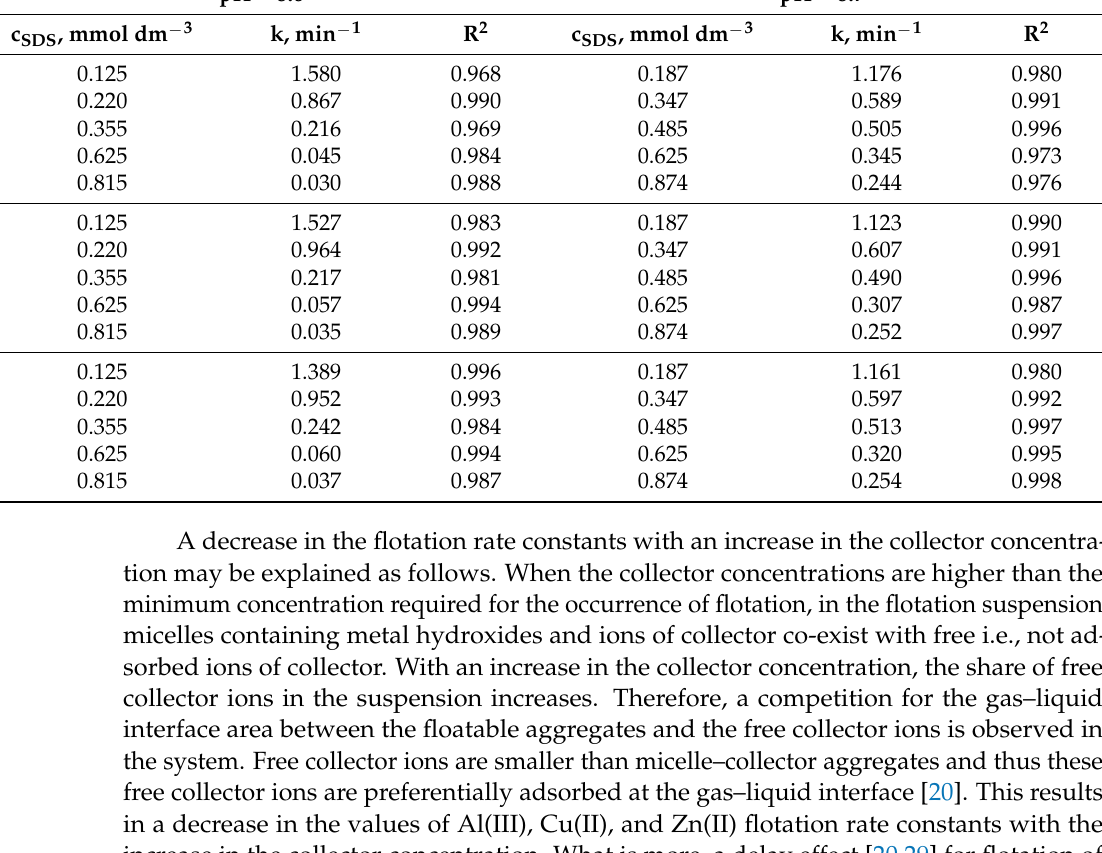
Table 5. Effect of collector concentration on the values of the flotation rate constants during flotation of Al(III), Cu(II), and Zn(II) mixture.